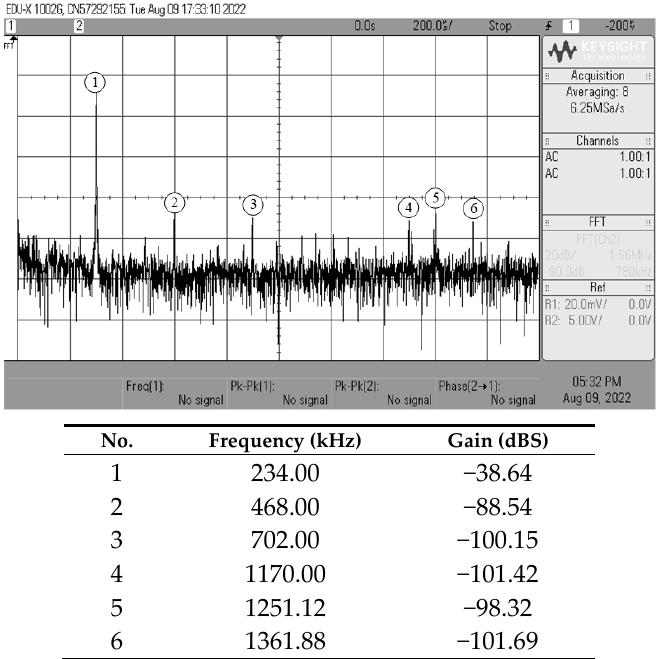
Figure 18. Experimentally observed frequency spectrum of i o(TAM) of the AP filter in TAM.